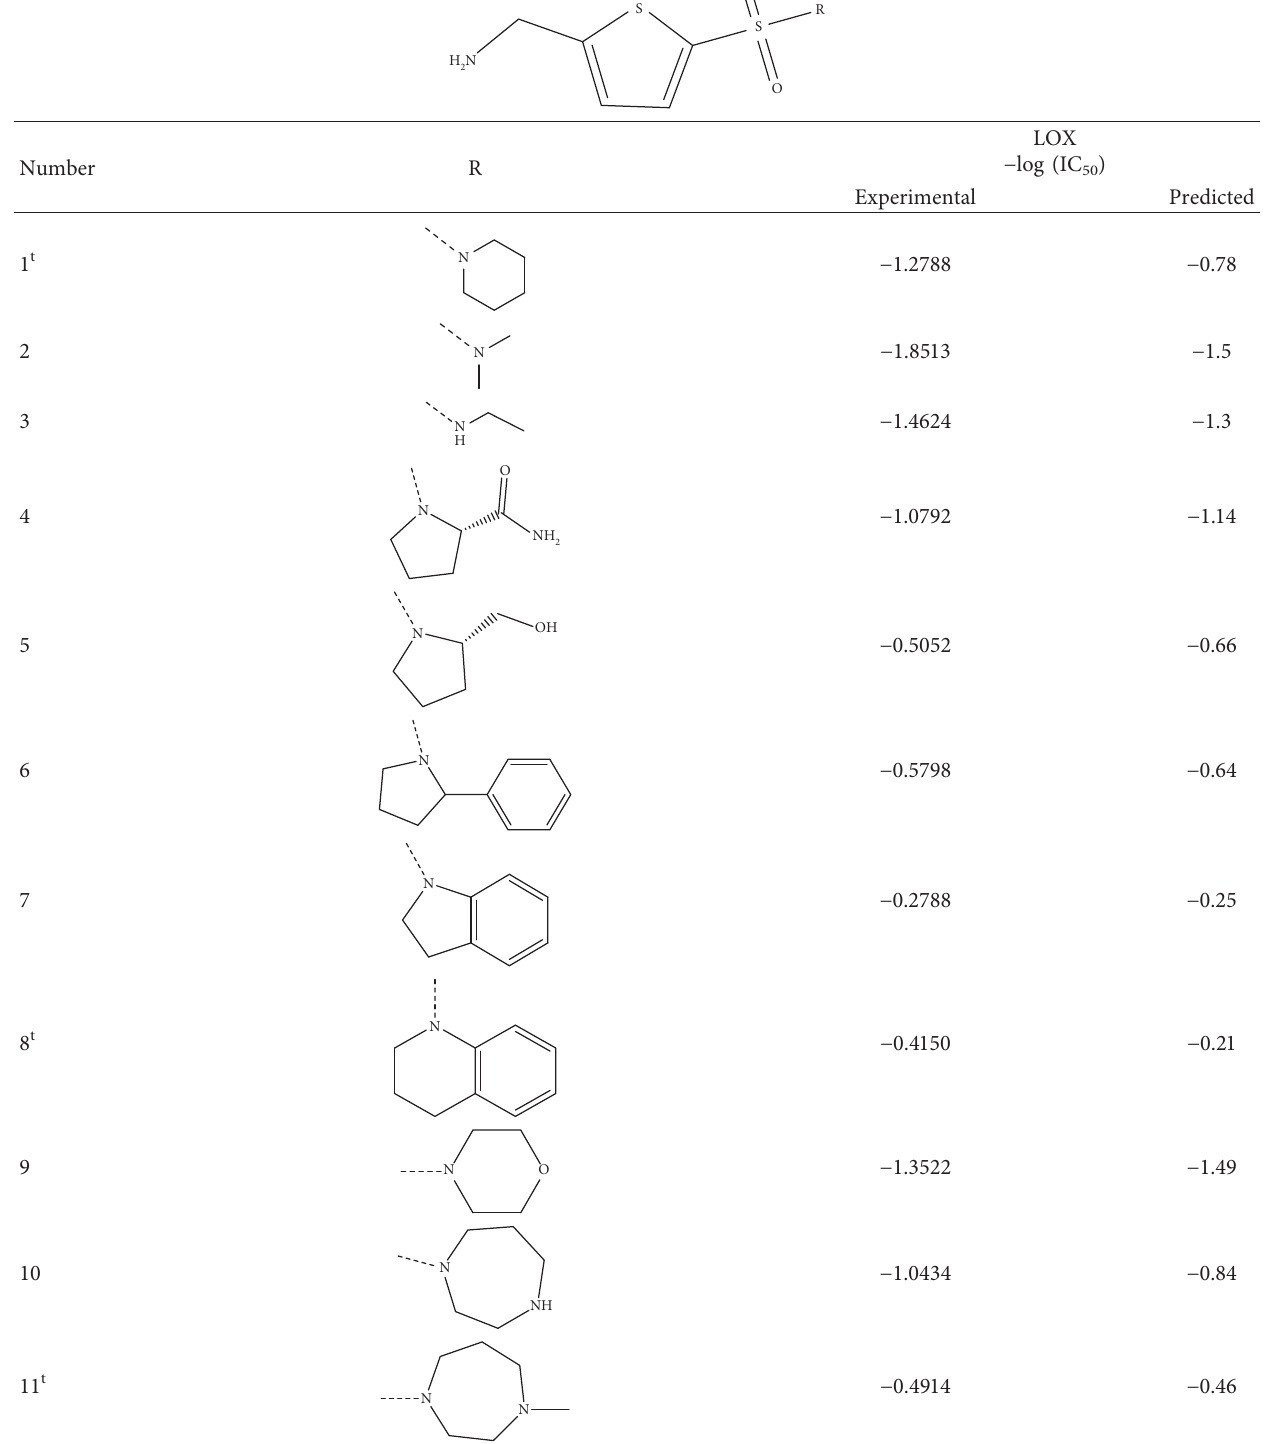
Table 1: Molecular structures, experimentally recorded, and theoretically predicted anti-LOX potency of the substituted amino-